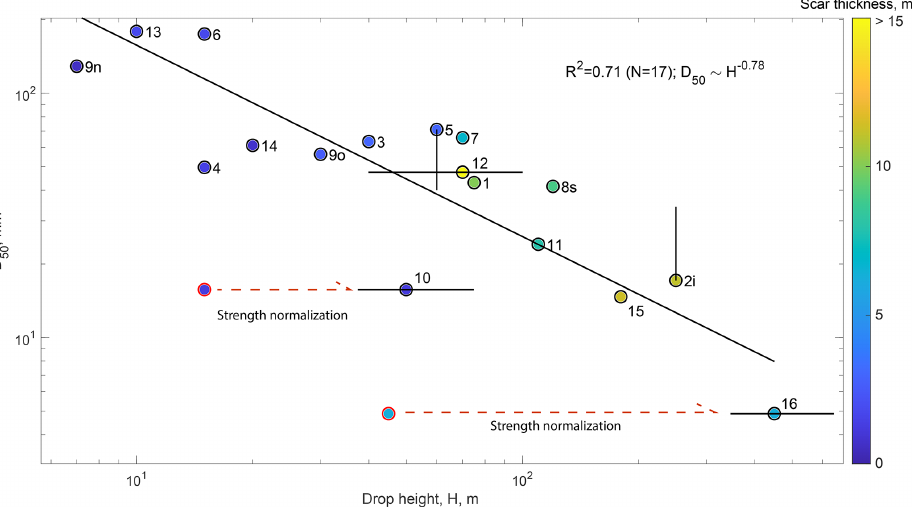
Figure 4. D 50 for the 17 landslides (color coded by scar thickness) in this study against the drop height of their center of mass. Results are similar for maximal drop height. The best fit (solid black line) and R 2 only consider the drop height rescaled by the landslide rock mass strength (black circles). The red circles show the original drop height for LS-10 and LS-16. Vertical bars show a factor of 2 uncertainty for LS-5s and LS-2i, for which there may be vertical segregation (see text). Horizontal error bars represent uncertainties in the drop height of LS-12 and the strength normalization of LS-10 and LS-16 (see Sect. 2).